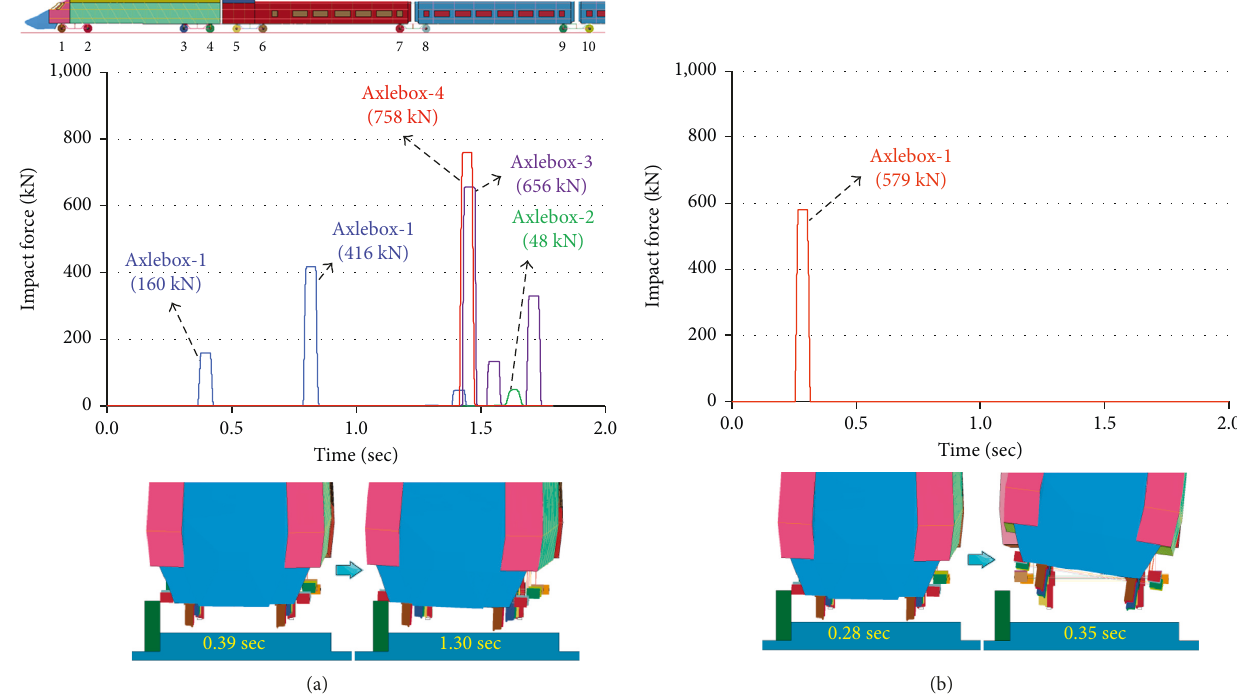
Figure 9: Derailment-collision behavior and impact force (distance effect 1). (a) Derailment-collision behavior 1. (b) Derailment-collision behavior 2.